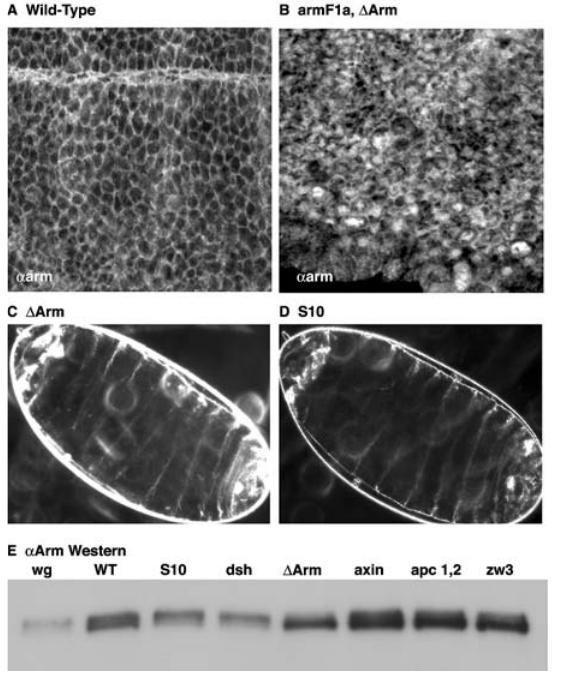
Figure 4. Expression of Arm D Arm Leads to the Nuclear Localization of Endogenous Arm Protein (A) Wild-type Arm protein appears in stripes that correspond to cells responding to Wg signaling. (B) Expression of Arm D Arm in an arm F1a background leads to the nuclear localization of endogenous Arm. (C and D) Dark-field images reveal that expression of both Arm D Arm and Arm S10 leads to similar naked cuticle phenotypes. (E) An anti-Arm Western blot showing a faster-migrating band, which correlates with endogenous Arm’s being active, and a slower- migrating band, which correlates with Arm’s being inactive. DOI: 10.1371/journal.pbio.0020095.g004